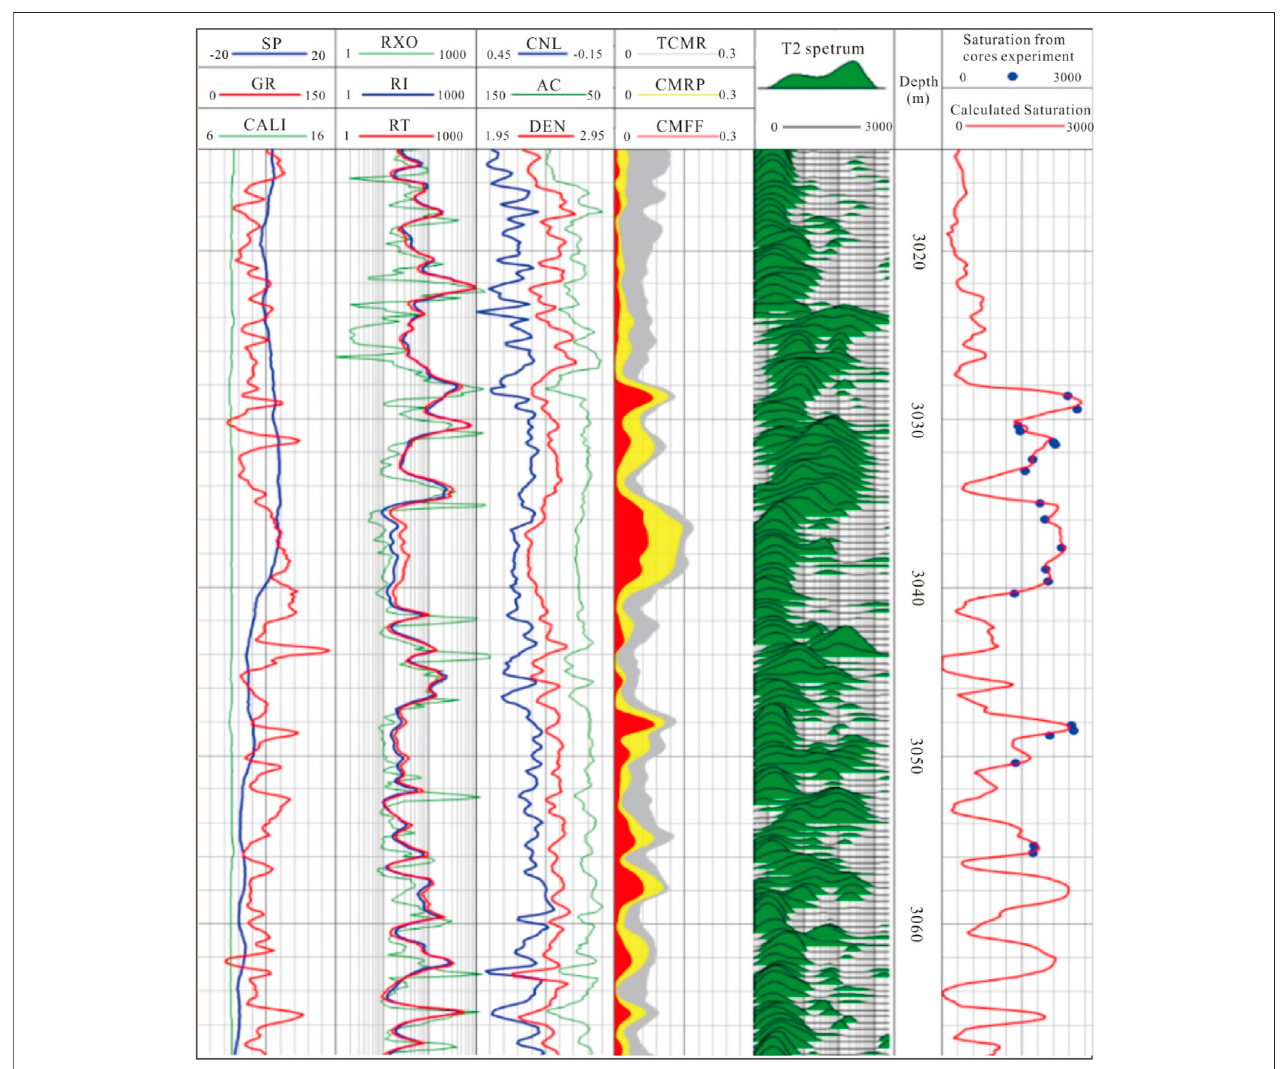
FIGURE 14 | Saturation processing map of